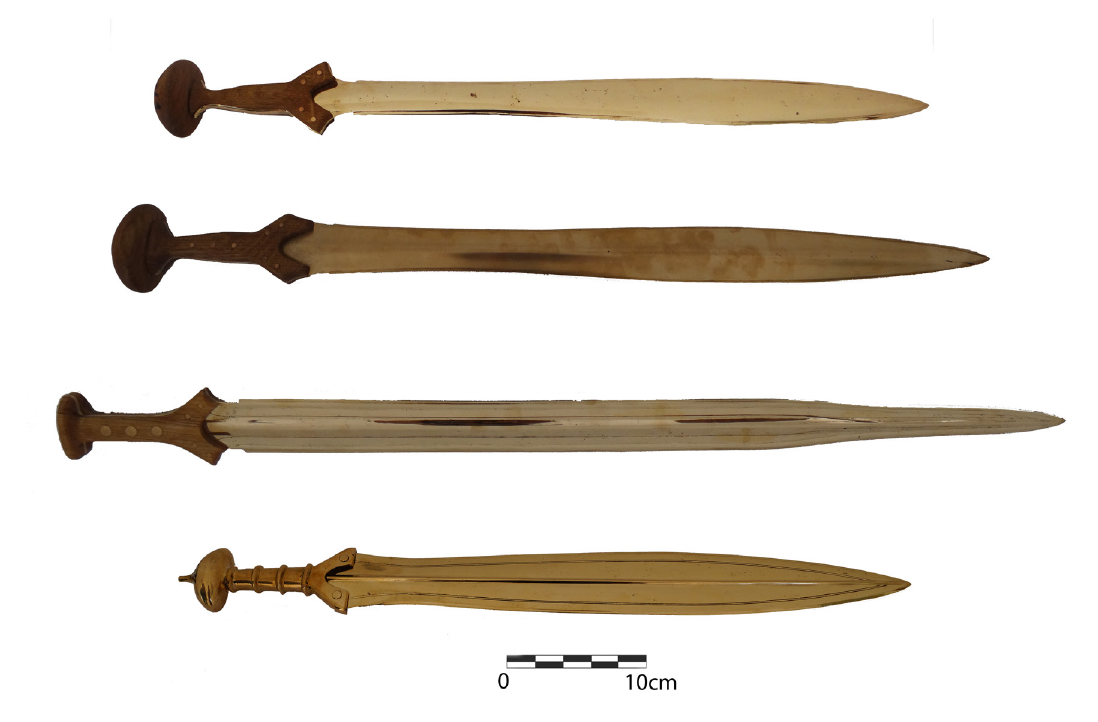
Figure 3. The four replica swords used for the Bronze Age Combat project; A: Type Wilburton; B: Type Ewart Park; C: Type Carp’s Tongue; D: Kemenczei’s Type S Vollgriffschwert (Image: R. J.